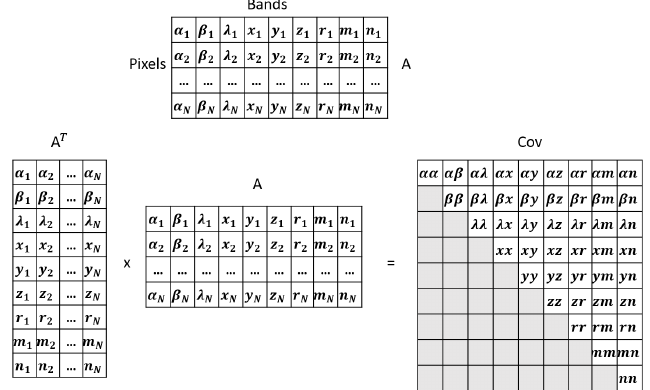
P i × Q i , where P , Q i = 1